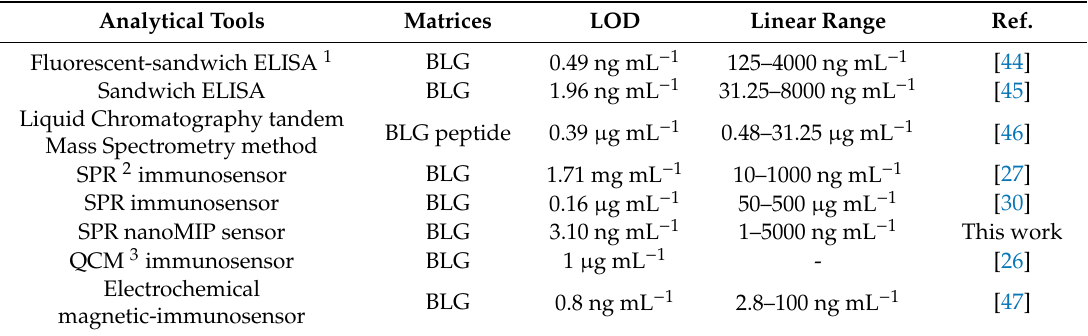
Table 2. List of recent developed analytical methods for BLG detection, including LOD and linear